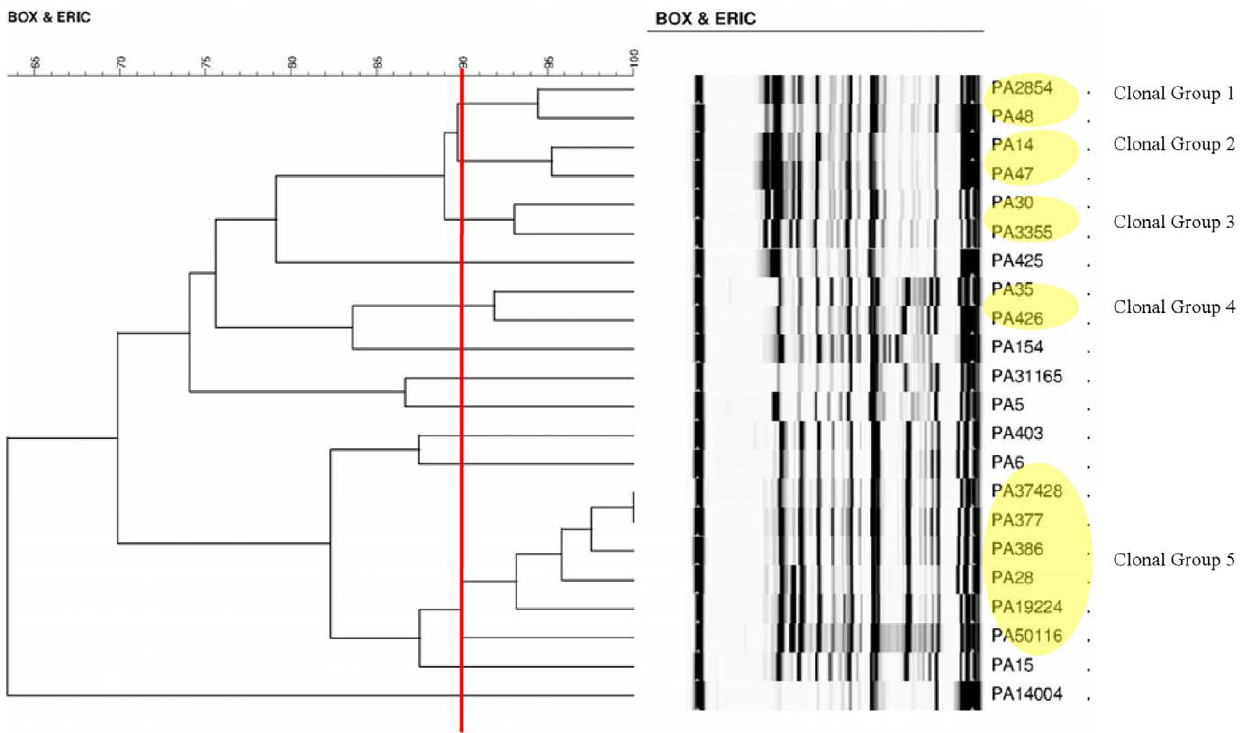
Figure 1. Phylogenetic Tree Diagram showing clonal groups. A yellow oval shape denotes a clonal group after applying a similarity index of $ 90% to PCR typing results.